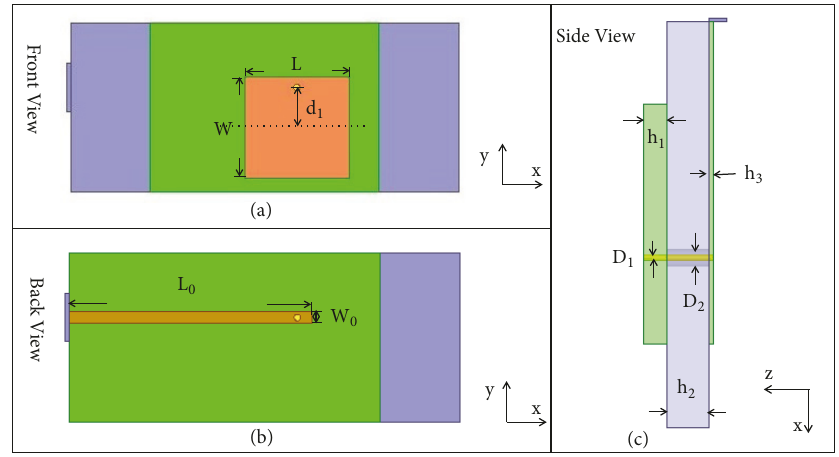
Figure 1: Schematic diagram of the cell antenna.